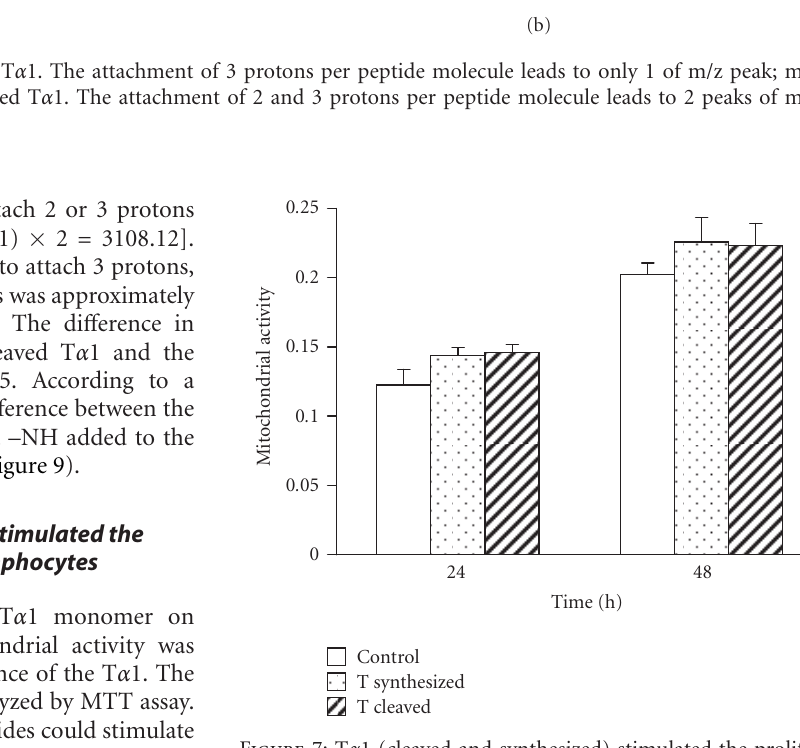
Figure 7: T α 1 (cleaved and synthesized) stimulated the prolifera- tion of mice spleen leukomonocytes. The mice spleen leukomono- cytes were treated with the indicated concentrations of T α 1 for 24 hours, and 48 hours. MTT assay was used to measure the mitochondrial activity. Significant stimulation of the mitochondrial activity, as compared to the control, occurred after 48 hours of T α 1 treatment. All the results are expressed as the mean ± SEM of data obtained in 3 independent experiments ( P < . 05, relative to